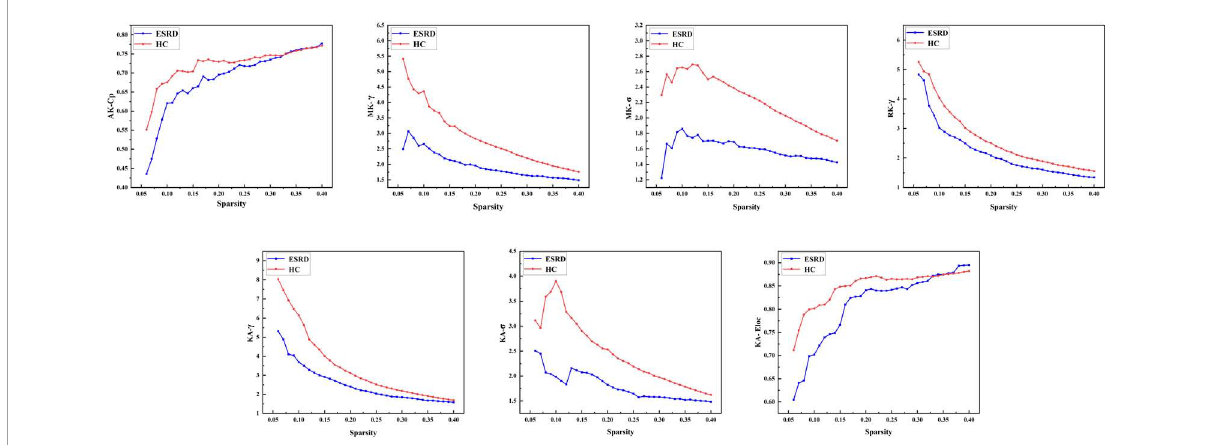
FIGURE2 Gray matter networks. Topological measures of gray matter networks with significant between-group differences were showed. Healthy controls are shown in red, and ESRD patients are shown in blue. AK, axial kurtosis; MK, mean kurtosis; RK, radial kurtosis; KA, kurtosis anisotropy; Cp, mean clustering coefficient; γ , standardized clustering coefficient; λ , standardized characteristic path length; σ , small-world properties; Eloc, local